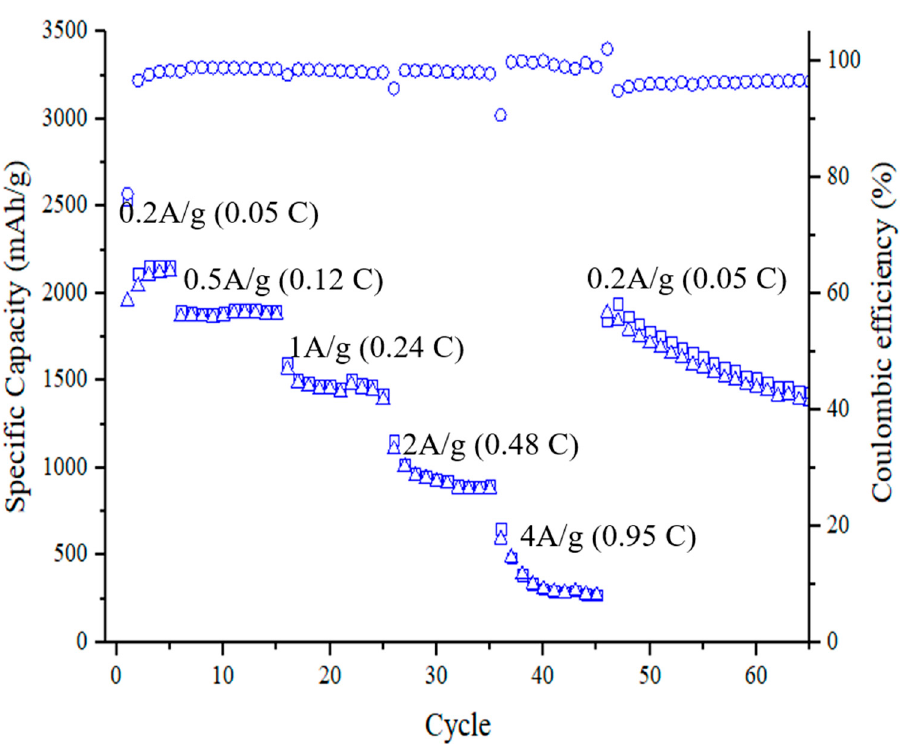
Figure 13. Cycling performance of the specific capacity and Coulombic efficiency of an anode made of silicon flakes with combined SiC and RF carbon coatings at discharge/charge rates ranging from 0.2 A/g (0.05 C) to 4 A/g (0.95 C). The discharge/charge rate is based on the total weight of active materials consisting of silicon flakes and combined SiC and RF carbon coatings.